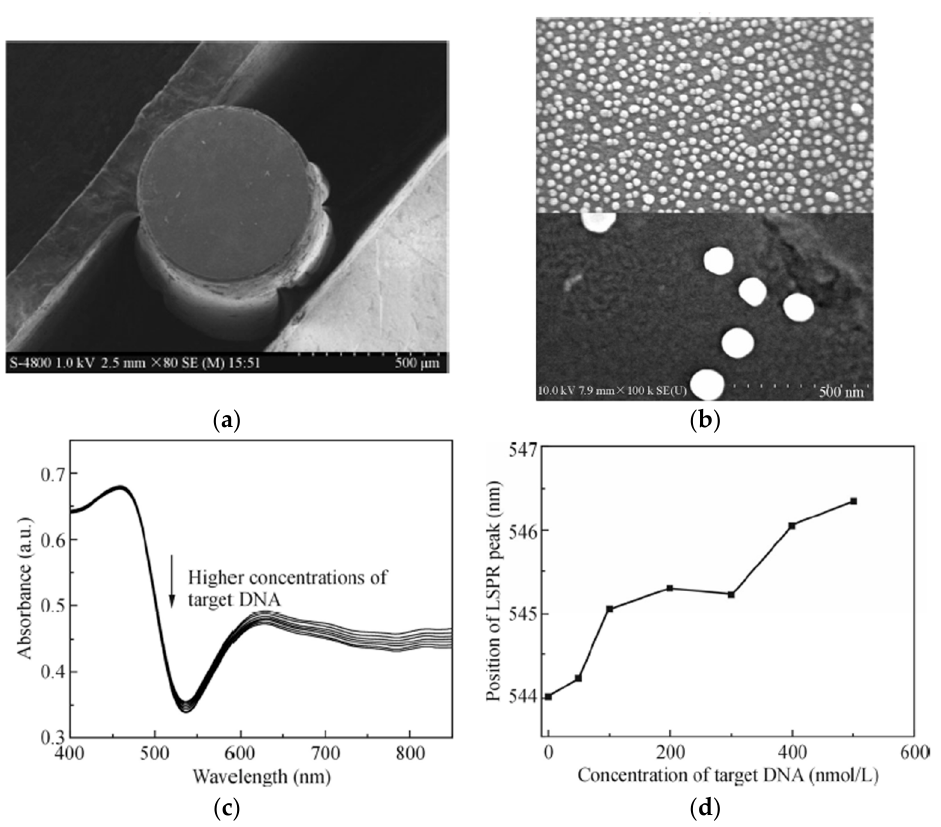
Figure 15. SEM images of the tip of ( a ) the fiber sensor and ( b ) the electrostatic self-assembly of monolayers of gold nanoparticles (AuNPs) of different sizes; ( c ) The absorbance spectra of the gold nanoparticles coated sensor for DNA concentration ranging from 0 to 500 nmol/L and ( d ) relationship between position of the LSPR peak and target DNA concentration. Reproduced from [138] with permission; Copyright Springer 2016.